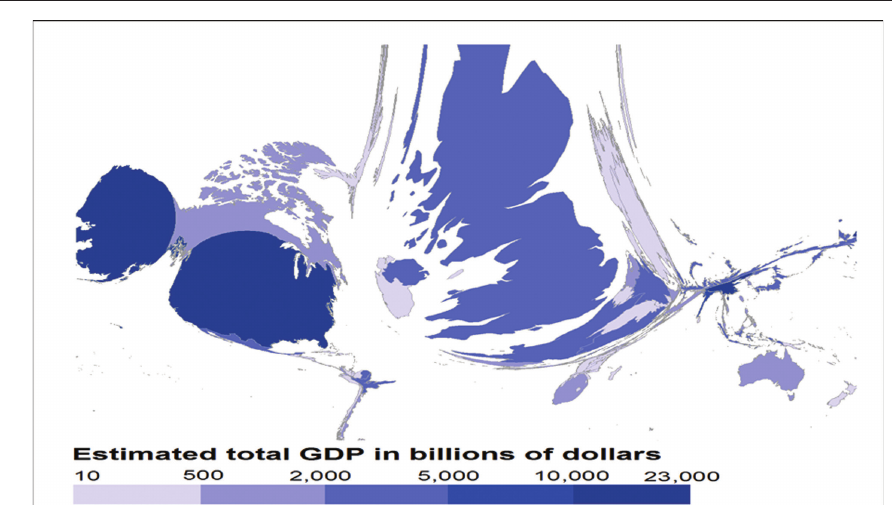
Figure 1: Cartogram depicting the relative distributions of citations on the 2017/18 Master’s in Public Health course (larger size of country represents higher number of citations; darker shade of country represents higher income status based on gross domestic product (GDP)) (Source: Authors,